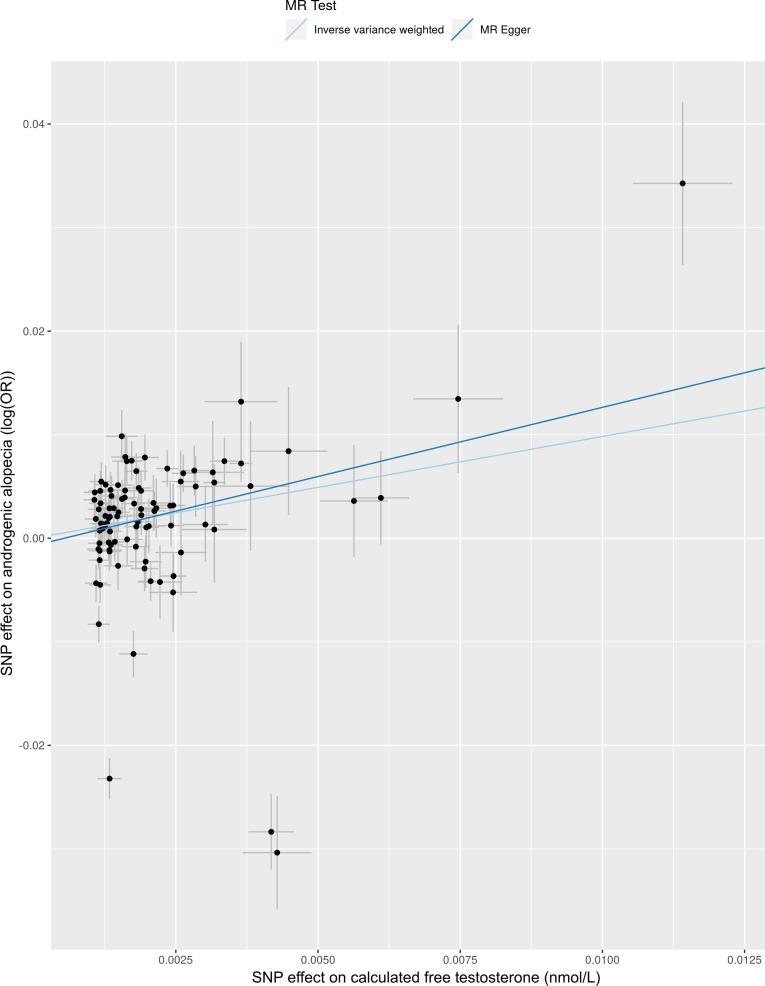
Comparison of effect of calculated free testosterone on androgenic alopecia using Mendelian randomization with IVW and Egger regression methods.